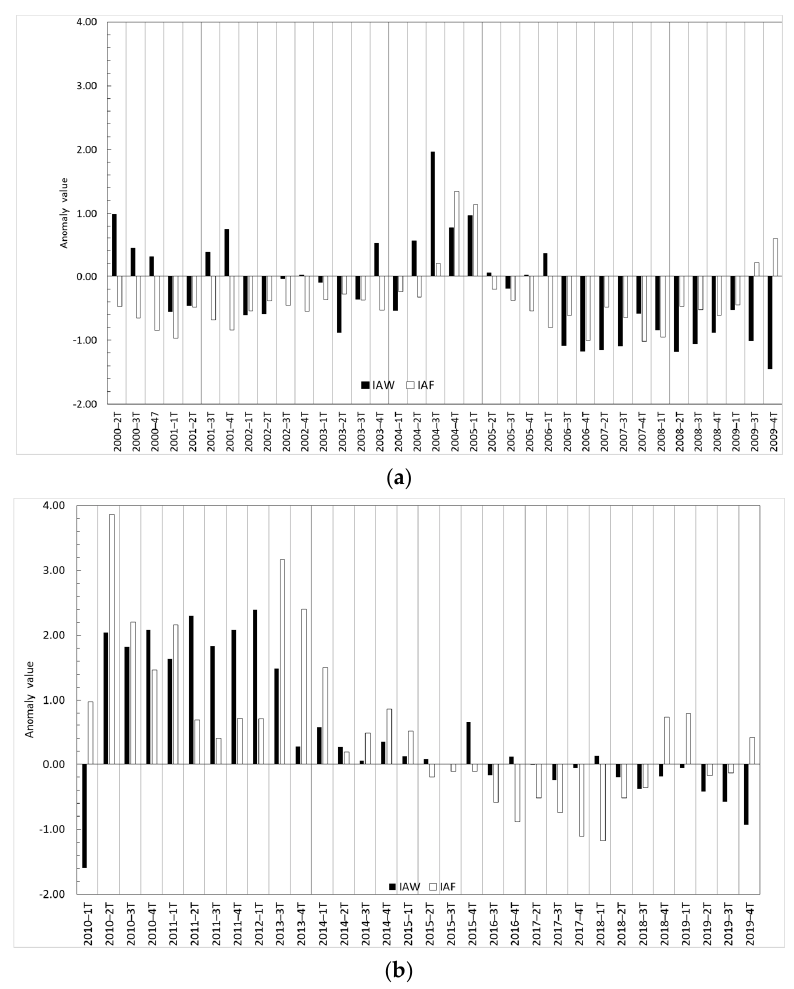
Figure 4. Water surface anomaly index (IAW) and flow anomaly index (IAF) in the period 2001–2010 ( a ) and 2011–2021 ( b ). Table 2. Spearman coefficient values among anomaly